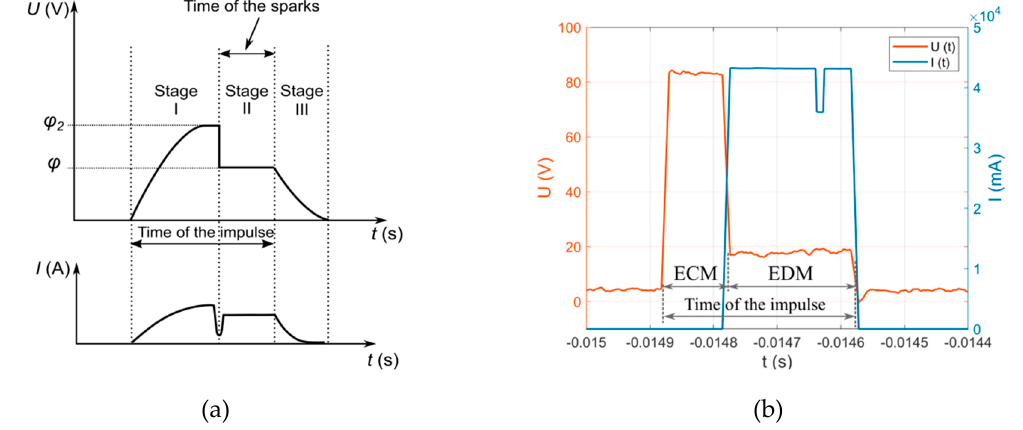
Figure 15. ( a ) Typical voltage and current waveform in a single impulse during the Electrochemical Discharge Machining (ECDM) process; ( b ) the recorded voltage and current waveform for the through hole parameters.